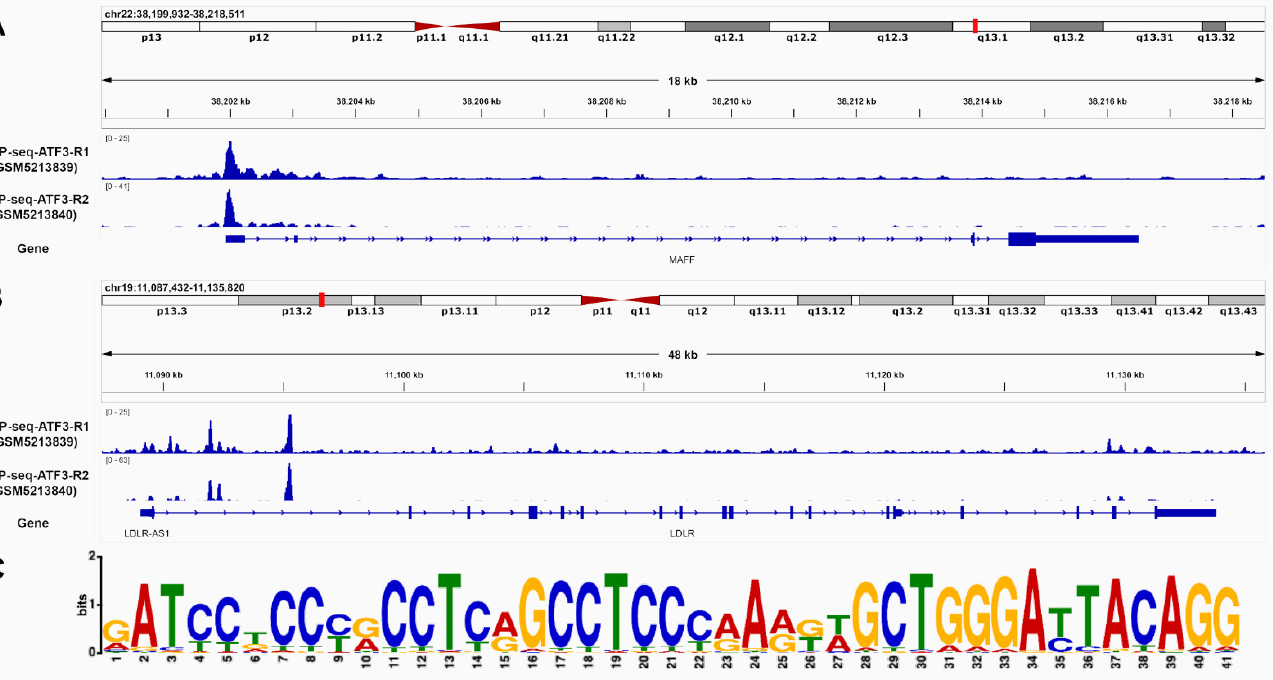
Figure 3. ATF3 has the ability to bind to MAFF and LDLR. Chromatin immunoprecipitation DNA- sequencing (ChIP-seq) data of human HepG2 cells supports potential binding of ATF3 in the promoter and intron regions of ( A ) MAFF and ( B ) LDLR. The matching motif ( C )was identified using publicly available ChIP-Seq data of the ATF3 gene in human HepG2 cells from ENCODE (Encyclopedia of DNA Elements). The height of the letter represents the frequency of the observed nucleotide in that position. ATF3: Activating transcription factor 3F; ChIP-Seq: Chromatine-immunoprecipitation sequencing; LDLR: low-density lipoprotein receptor; MAFF: MAF basic leucine zipper transcription factor F.